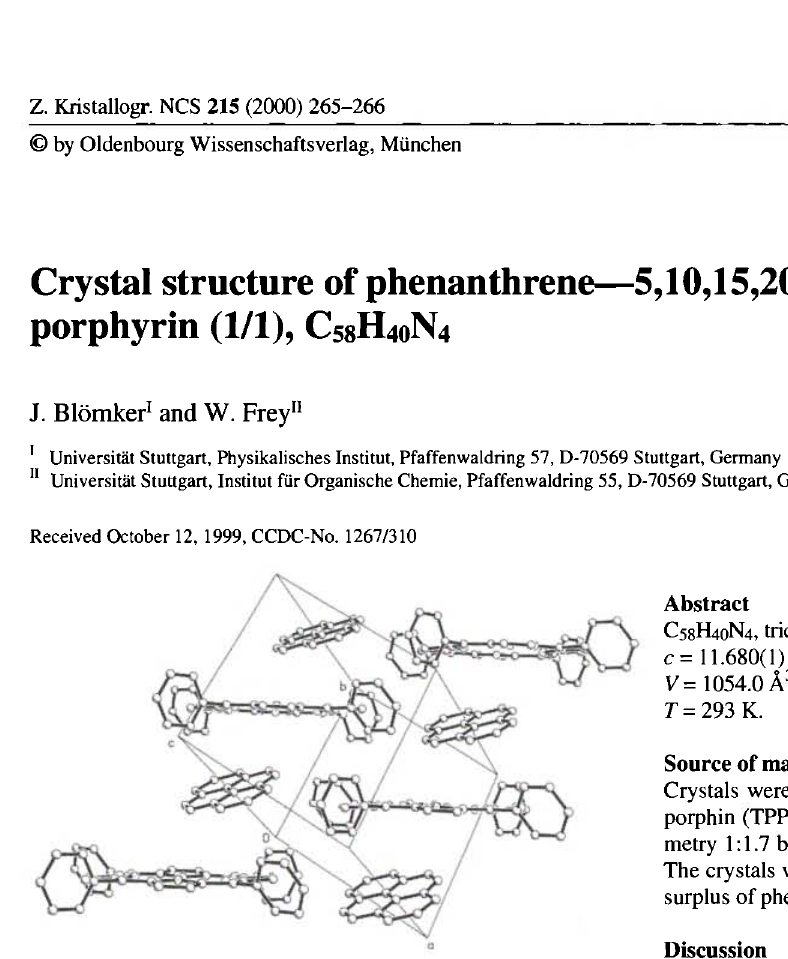
Fig. 1. TPP layers with molecules of phenantrene in between.